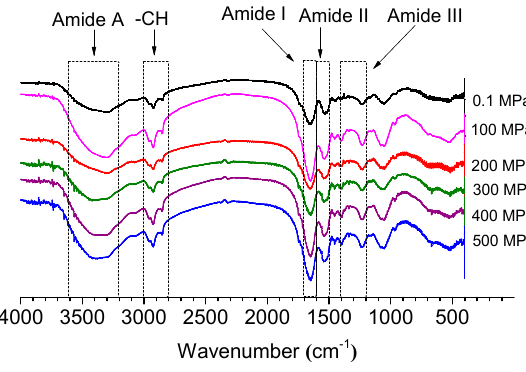
Figure 4. The FTIR spectrum of control and HP treated oyster proteins.